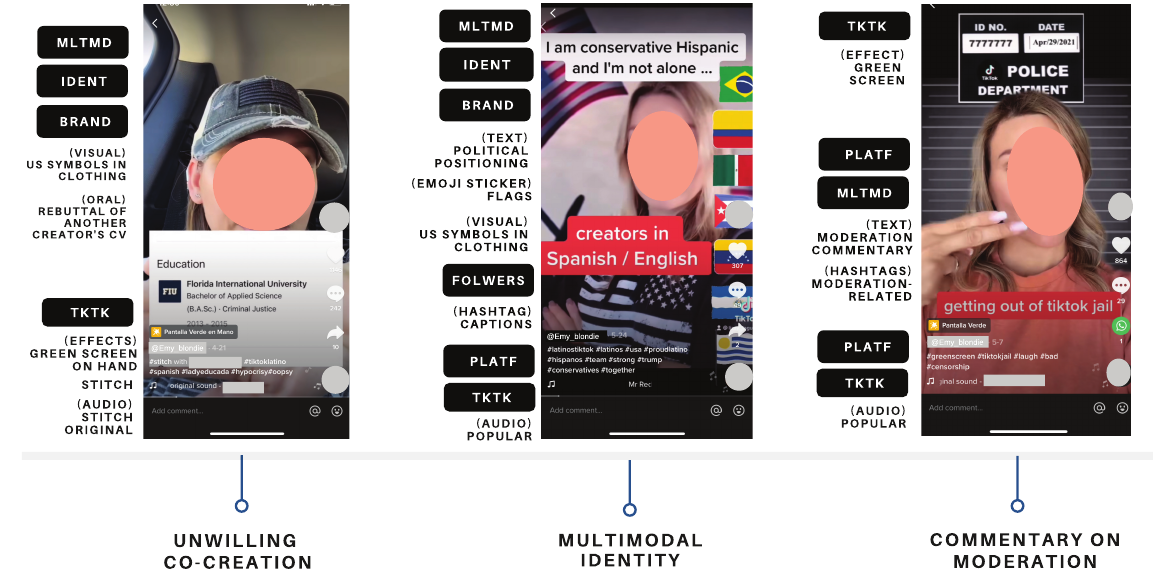
Figure 5. Emy_blondie’s use of multimodal elements and TikTok